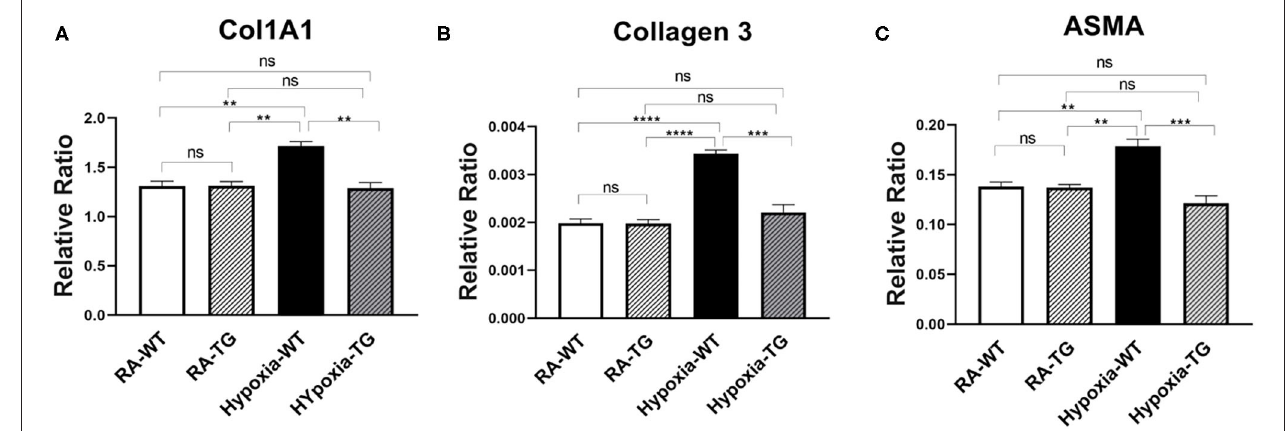
FIGURE 1 | RT-PCR for markers of fibrosis—Collagen 1, Collagen 3, and ASMA. Adult male C57B6 mice, WT, and EC-SOD transgenic mice (TG) were exposed to FiO 2 10% hypoxia for 21 days (WT). The control group was composed of animals housed in room air (RA). Quantitative RT-PCR was used to assess gene expression analysis of Collagen 1 (A) , Collagen 3 (B) , and ASMA (C) in the right ventricular tissue. All experiments n = 5. Data represents mean ± SEM. * P < 0.05, ** P < 0.01, *** P < 0.001, **** P < 0.0001.